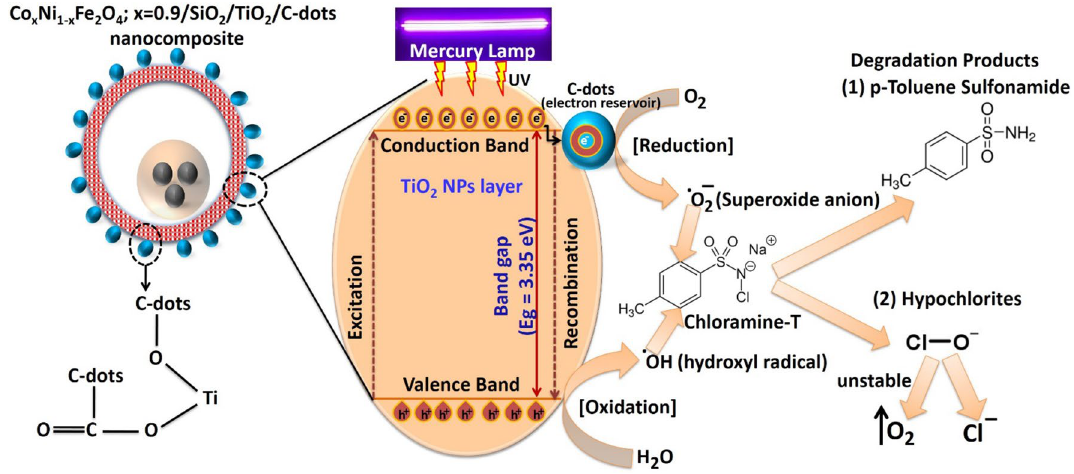
Figure 14. Proposed mechanism of photocatalytic degradation of chloramine-T with the prepared